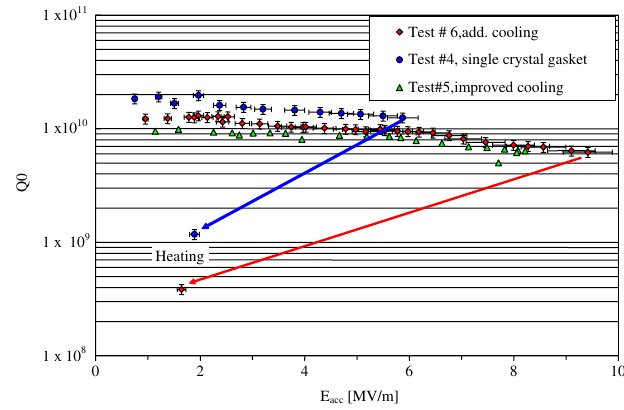
FIG. 7. (Color) Results from tests with single crystal gaskets and improved